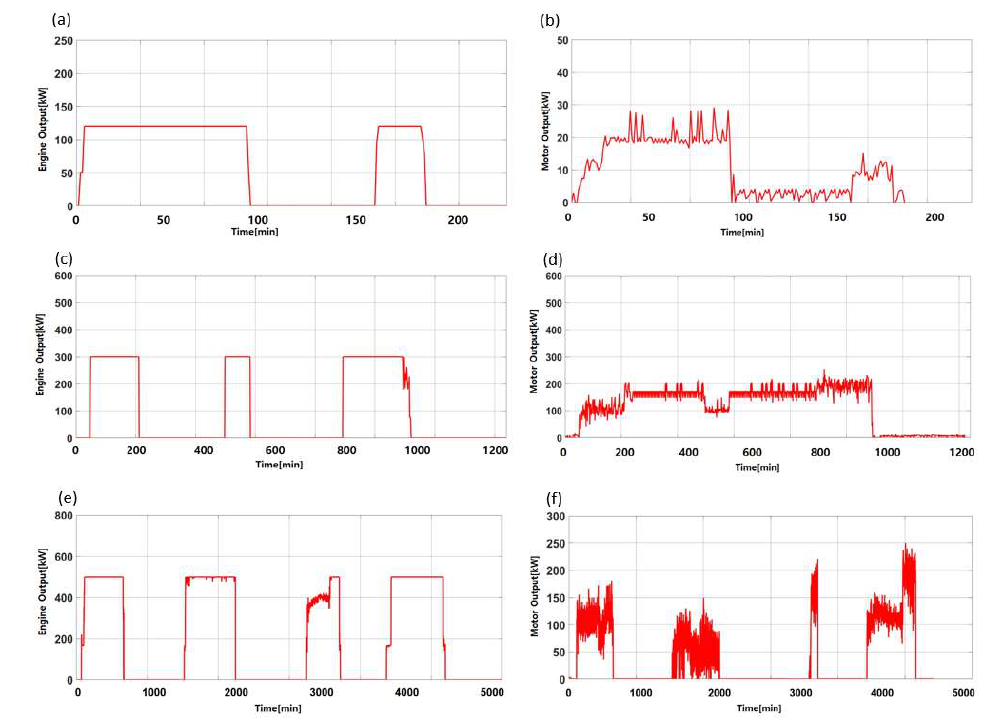
Figure 8. Outputs of engine and motor in battery hybrid system with ECMS control: ( a ) engine output of 4.99 tons, ( b ) motor output of 4.99 tons, ( c ) engine output of 9.77 tons, ( d ) motor output of 9.77 tons, ( e ) engine output of 47 tons, and ( f ) motor output of 47 tons.